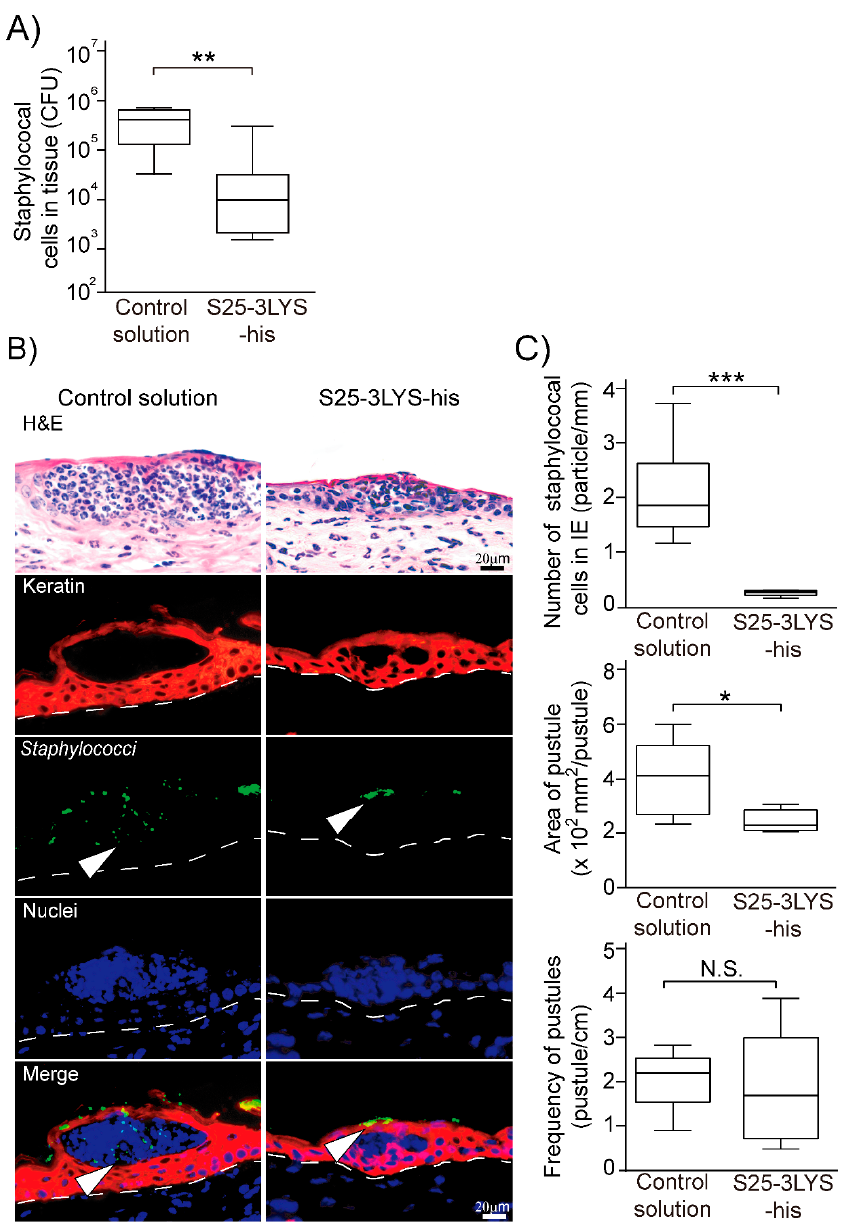
Figure 2. Evaluation of S25-3LYS-his treatment in an impetigo mouse model. ( A ) The density of staphylococcal cells in mouse skin. The densities of viable Staphylococcus spp. were measured using mannitol salt agar. The statistical significance is indicated as “**” ( P < 0.01). Of note, when the total bacteria in the mouse skin was measured using tryptic soy agar, there was no statistical difference between the S25-3LYS-his-treated and control groups ( P > 0.05; see Figure S4 in the supplemental material). ( B ) Pathological analysis of mouse skin tissues in the control solution (left) and S25-3LYS-his-treated solution (right). Representative photographs are shown. In the top micrographs, the tissues stained with hematoxylin and eosin (H&E) are shown. In the second from the top to the bottom micrographs, keratin, staphylococci, and nuclei-specific staining are shown in red, green, and blue, respectively. Staphylococci are indicated by white arrowheads (i.e., images on the third and the fifth rows from the top). The dotted lines indicate the basement membranes. ( C ) Staphylococcal cells in the intra-epidermal (IE) region, the area of pustules, and the frequency of pustules were measured by pathological analysis. Statistical significance is shown on the graph (*, P < 0.05; ***, P < 0.005); no statistical significance is indicated as